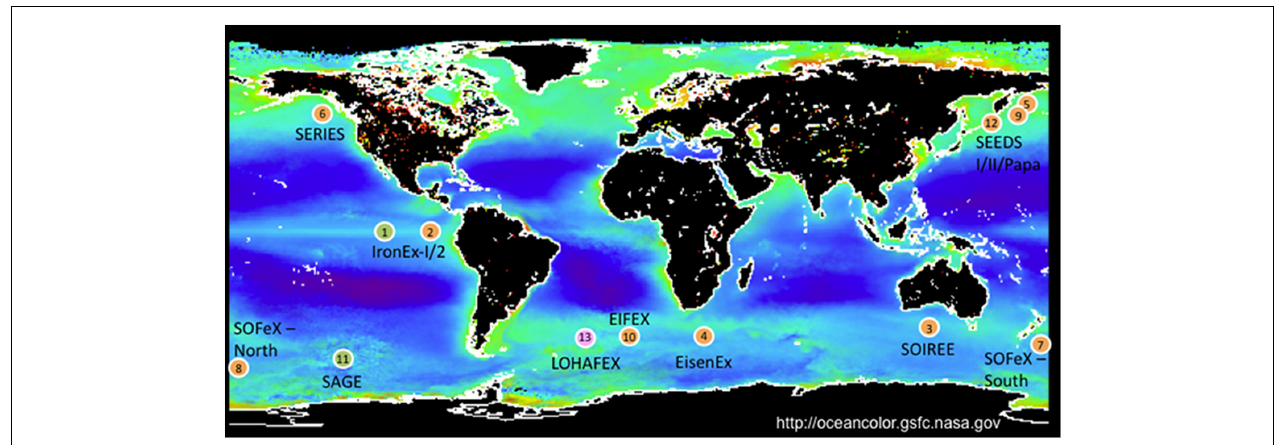
FIGURE 1 | Examples of iron limitation in the ocean as evidenced by rapid growth of diatoms and other plankton after iron fertilization experiments. Circle color indicates dominant plankton in resultant blooms: orange – diatoms; green – picophytoplankton; pink – zooplankton. 1 –